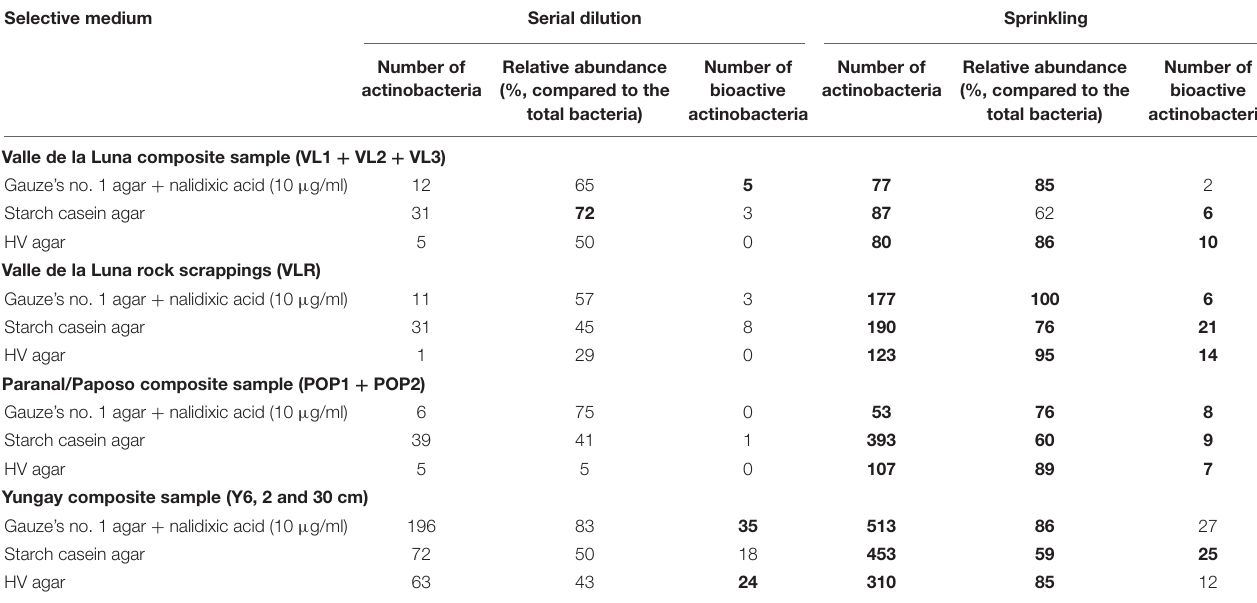
TABLE 2 | Comparison of serial dilution and sprinkling technique with number and relative abundance of actinobacterial colonies (cfus per gram of dry weight environmental samples) growing on selective media prior to incubation at 28 ◦ C for 14 days (modified from Xie,